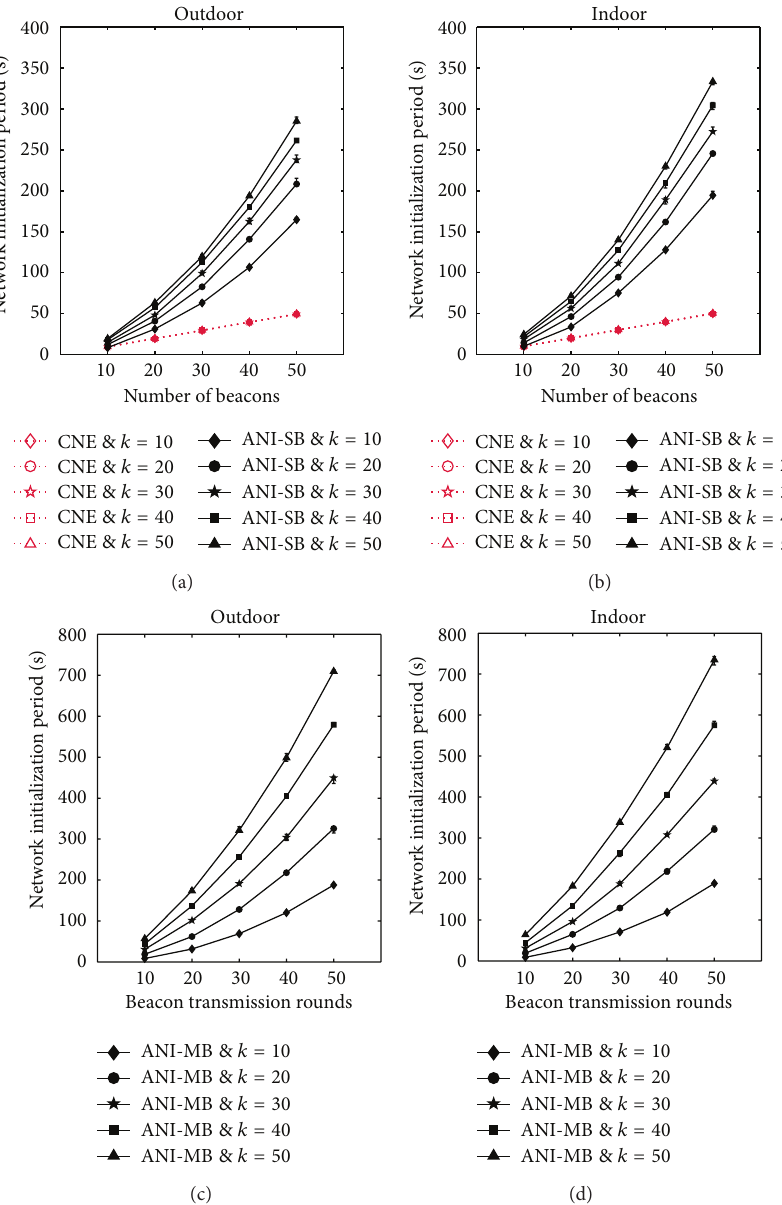
Figure 4: Neighbor discovery and link quality estimation period by ANI-SB, ANI-MB and CNE protocols in one-hop topology networks deployed in outdoor and indoor